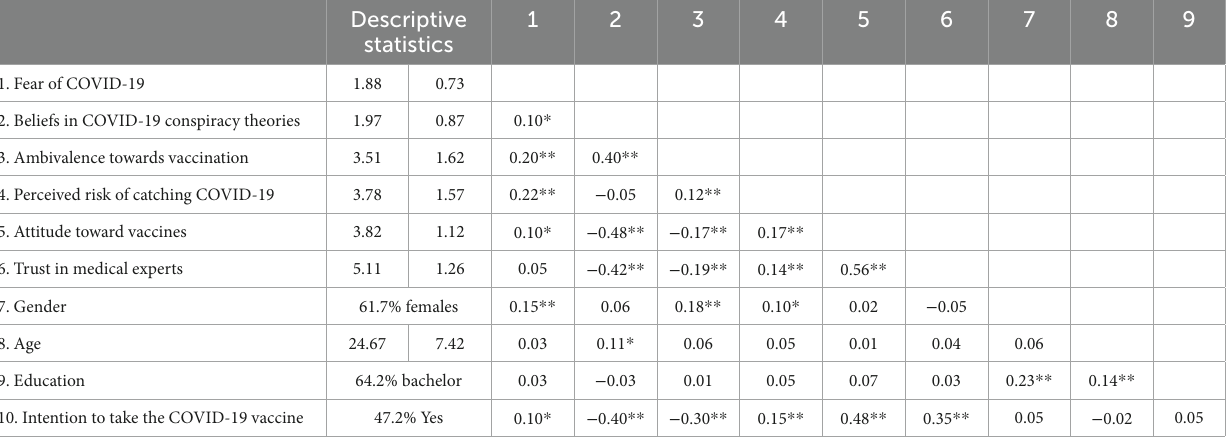
TABLE 2 Descriptive statistics and associations between study